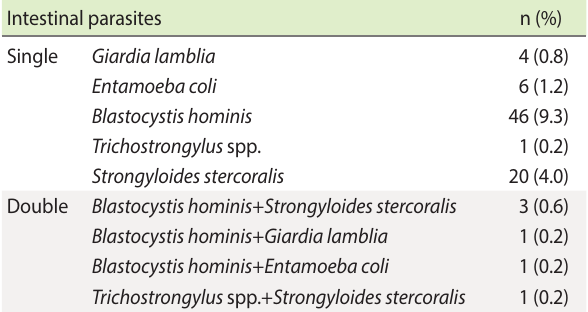
Table 2. Prevalence of infections with different species of intestinal parasites in patients receiving immunosuppressive drugs in